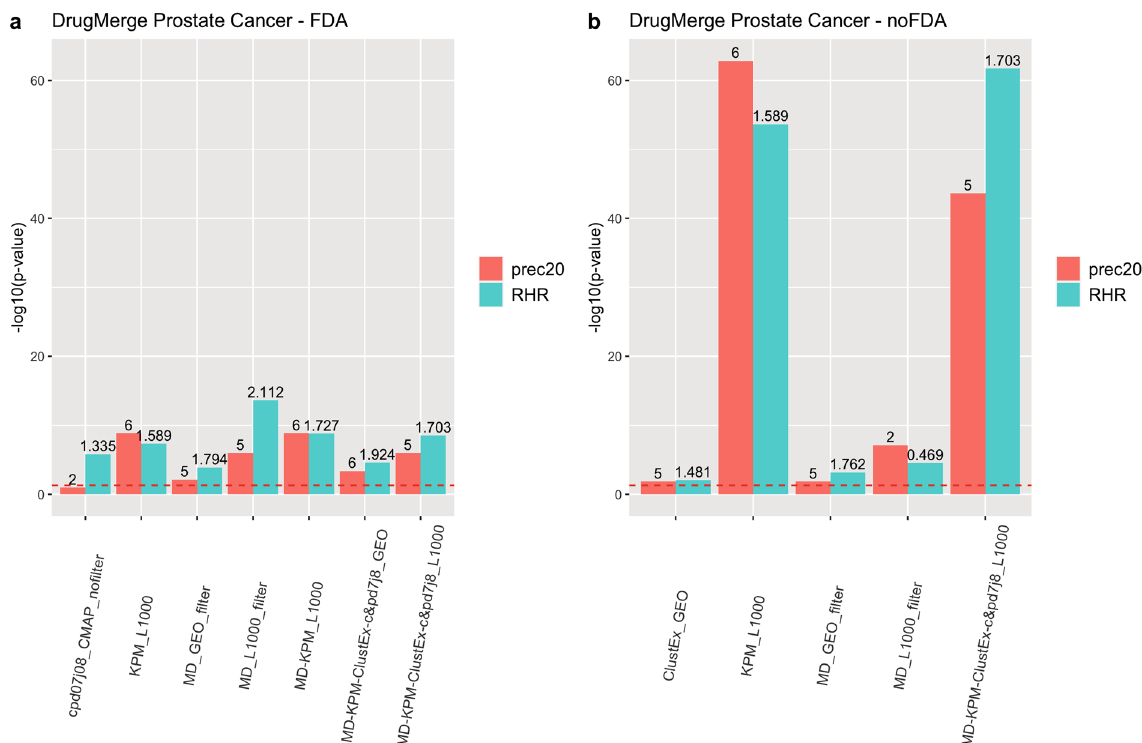
Figure 3. DrugMerge performance on Prostate Cancer data. The bars represent the − log 10 ( p value ) with respect to the precision@20 (red), and the RHR (light blu). On the x-axis, different algorithms or combinations of them are shown. The numbers on the top of the bars show the absolute values of precision@20 or RHR. The dotted red line represents the limit of significance ( − log 10 ( 0.05 ) ). All the bars above the dotted line show a significant p-value. The ( a ) panel represents the DrugMerge performance when only FDA-approved drugs are considered; ( b ) when all drugs (without any FDA filtering) are considered. The plot has been generated by the ggplot2 81 R